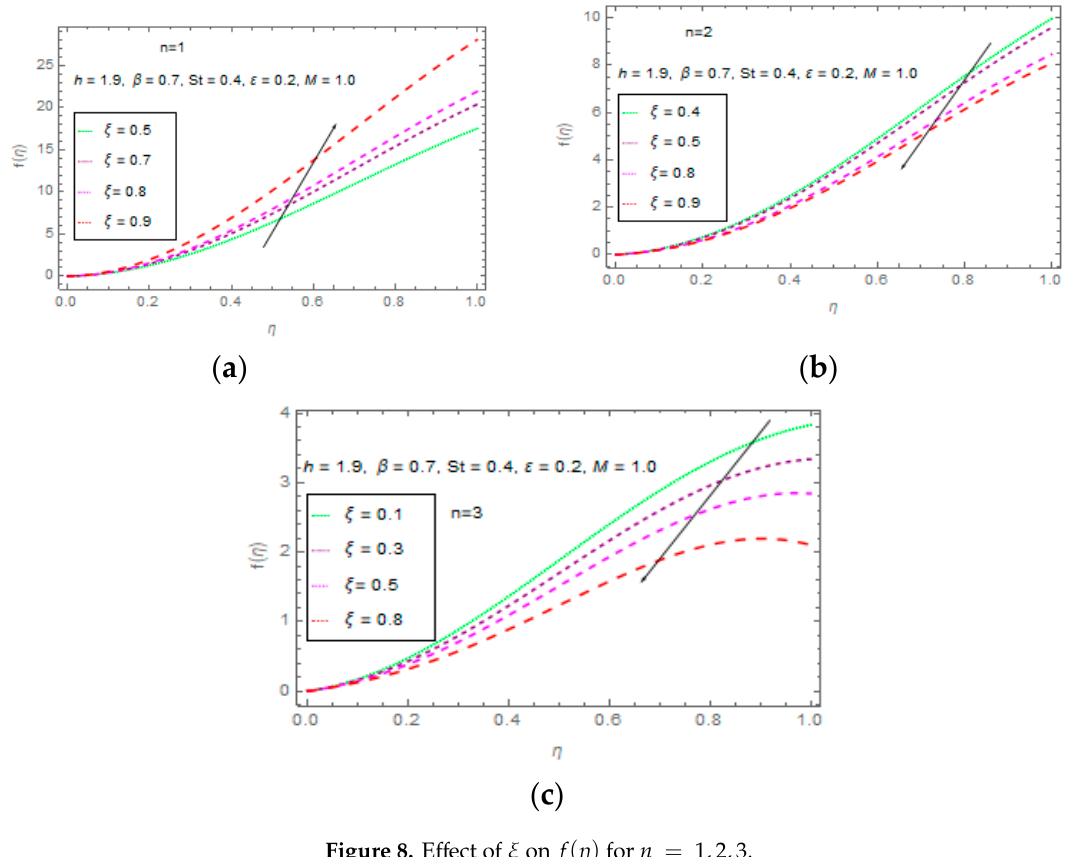
Figure 8. Effect of 𝜉 on 𝑓(𝜂) for 𝑛 = 1,2,3 .